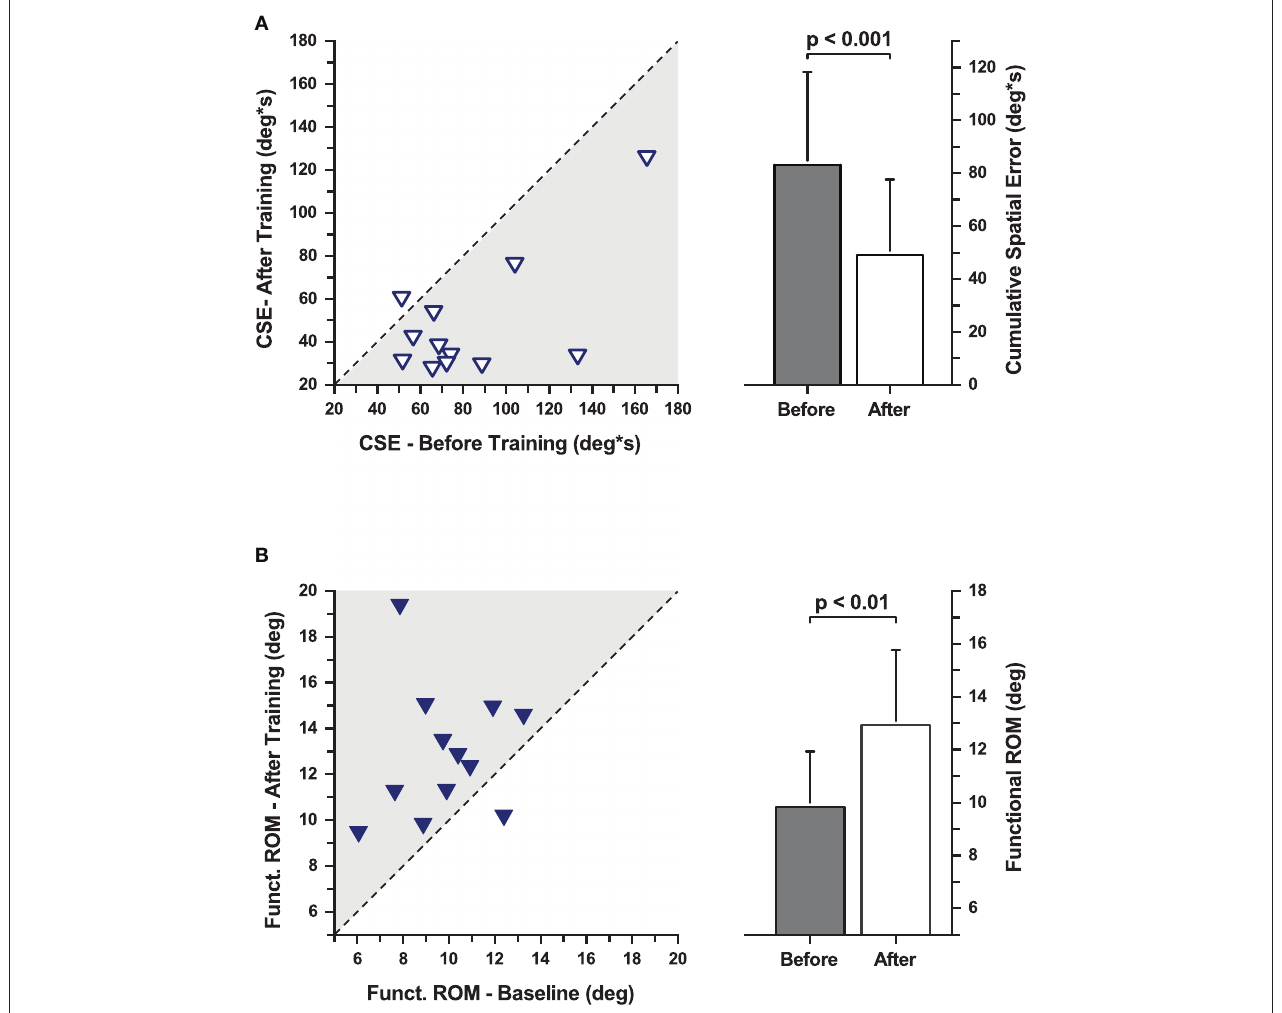
FIGURE 2 | Cumulative spatial error (CSE) and functional range of motion during the evaluation of task-specific motor learning. ( A, Left) CSE changes with training. Each data point represents a participant’s CSE before and after training. The dashed line indicates the line of equality representing a no change in CSE as a function of training. (Right) Mean CSE across all participants before and after training. CSE decreased significantly after training. ( B, Left) Functional range of motion changes with training. Each data point represents a participant’s functional range of motion before and after training. The dashed line indicates the line of equality representing a no change as a function of training. (Right) Mean functional range of motion increased significantly after